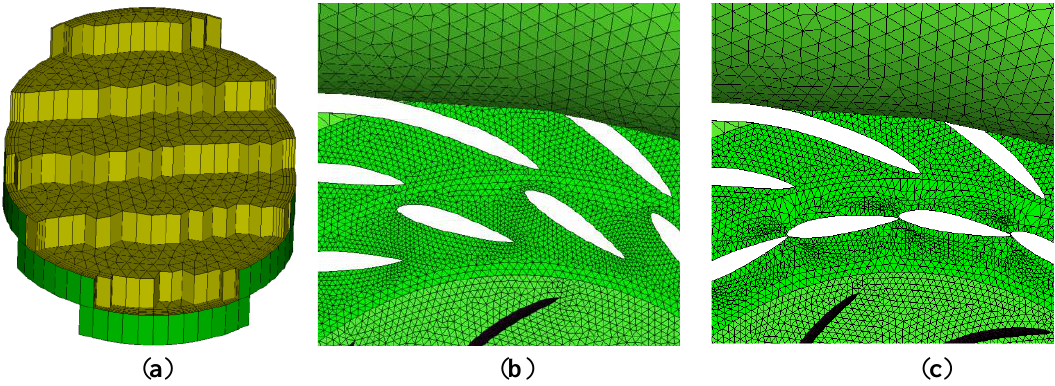
Figure 5. ( a ) Local section of pipeline grid; ( b ) Grid near the guide vane in the initial time; ( c ) Grid near the guide vane at full closed time.